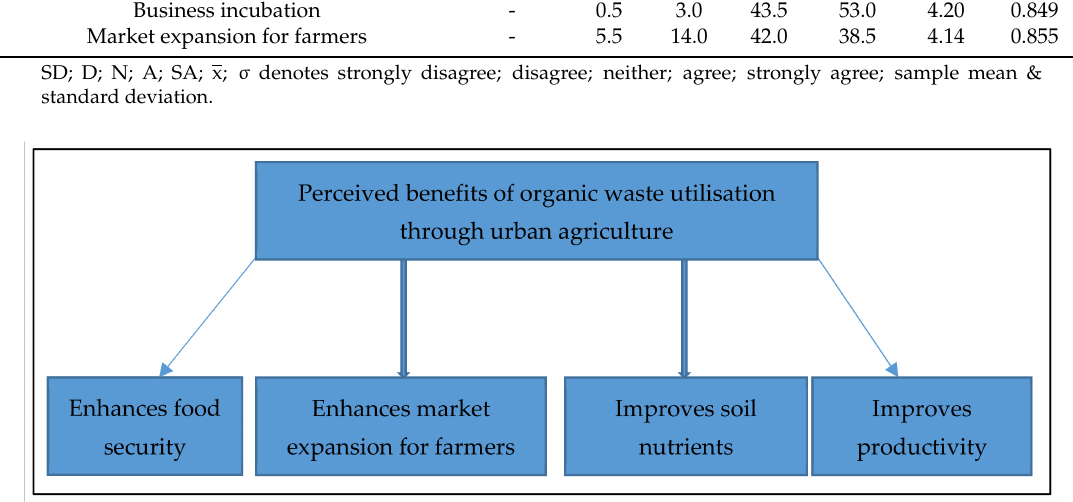
Figure 6. Perceived benefits of organic waste utilisation through urban